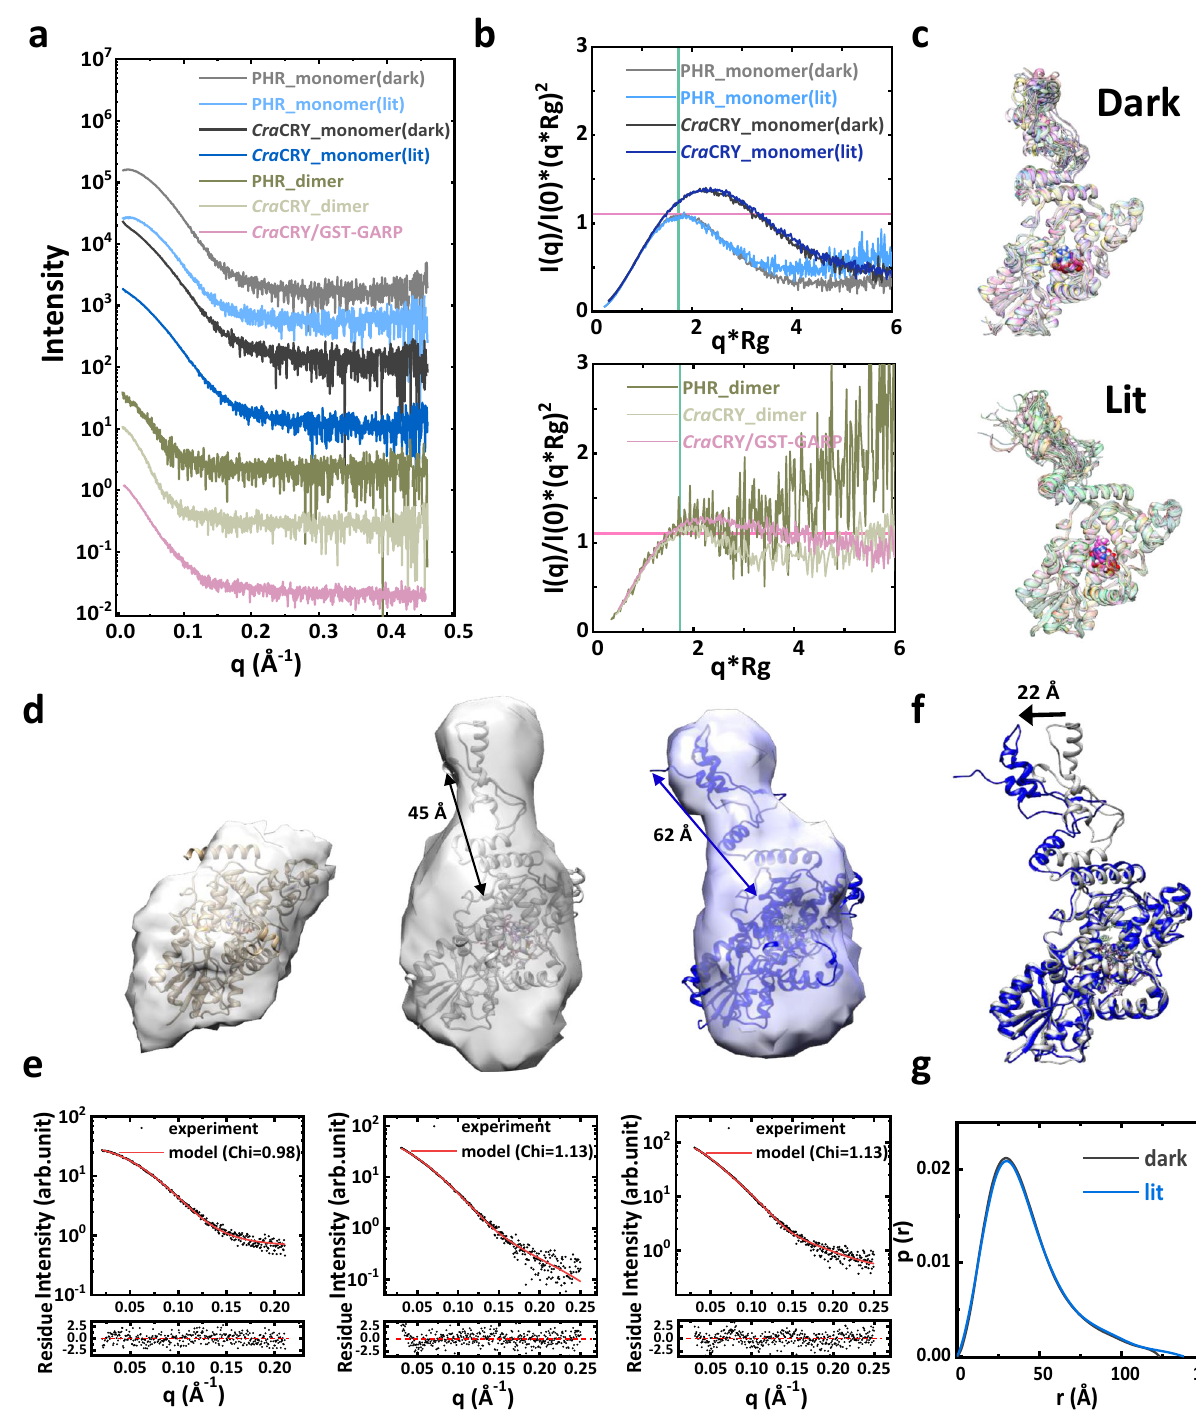
Fig. 2 SAXS data and modeling. a SAXS data in the range of measurement. The intensities were scaled for presentation purposes. b Dimensionless Kratky plots for the SAXS data. c Structure ensembles obtained from SAXS-driven MD simulations . d Reconstructed low-resolution models superposed to the crystal structure of PHR and the representative models of Cra CRY in dark and lit states, shown in panels from left to right, respectively. e The theoretical SAXS pro fi les (solid red) calculated from the atomic models, fi tted to experimental data (black dots). The residual plots (I expt − I model )/ σ expt are shown underneath each fi tting result. The fi gures are arranged left to right showing the SAXS data of PHR, Cra CRY in dark, and Cra CRY in lit, respectively. f The positions of CTE in representative structures, with dark state structure shown in gray color, and the lit state in blue (see panel d ). g The pairwise distance distribution function p(r) derived from SAXS data in dark and lit